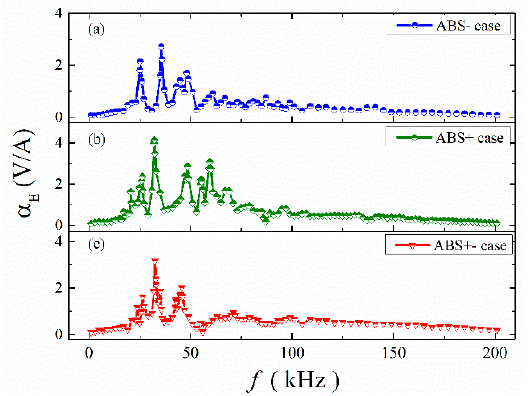
Figure 5. The frequency dependences of α E for ME structures in different conditions: ( a ) ABS- case; ( b ) ABS+ case; ( c ) ABS+- case. Table 1. The resonance frequencies in ME structures with ABS